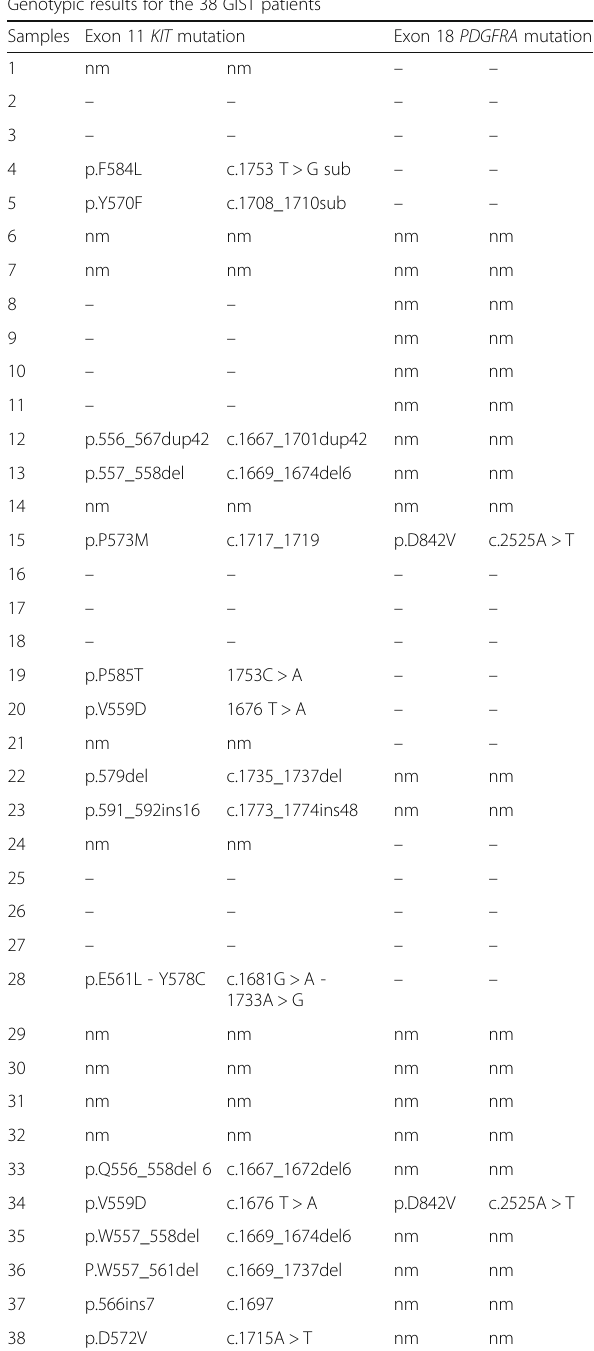
Table 1 Type of mutation, genomic location and the position of the codon in the 38 samples used in the study Genotypic results for the 38 GIST patients Samples Exon 11 KIT